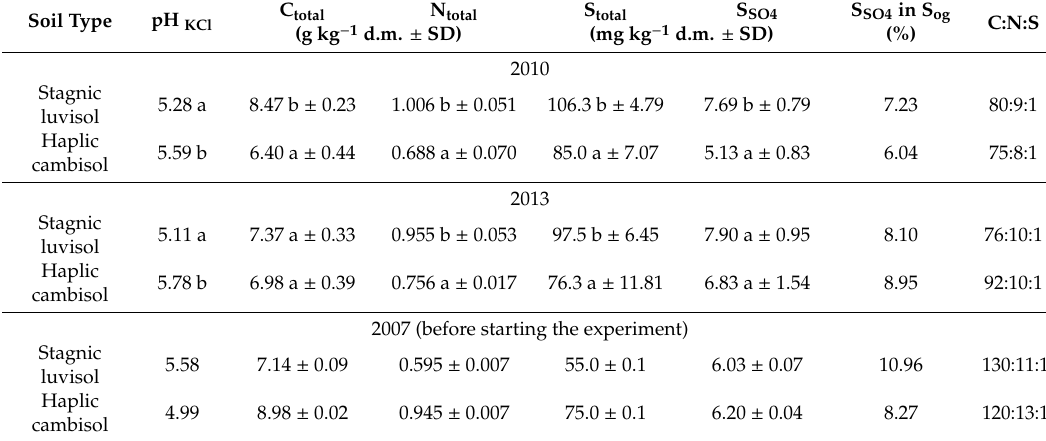
Table 3. Means and SDs of selected soil properties under di ff erent soil